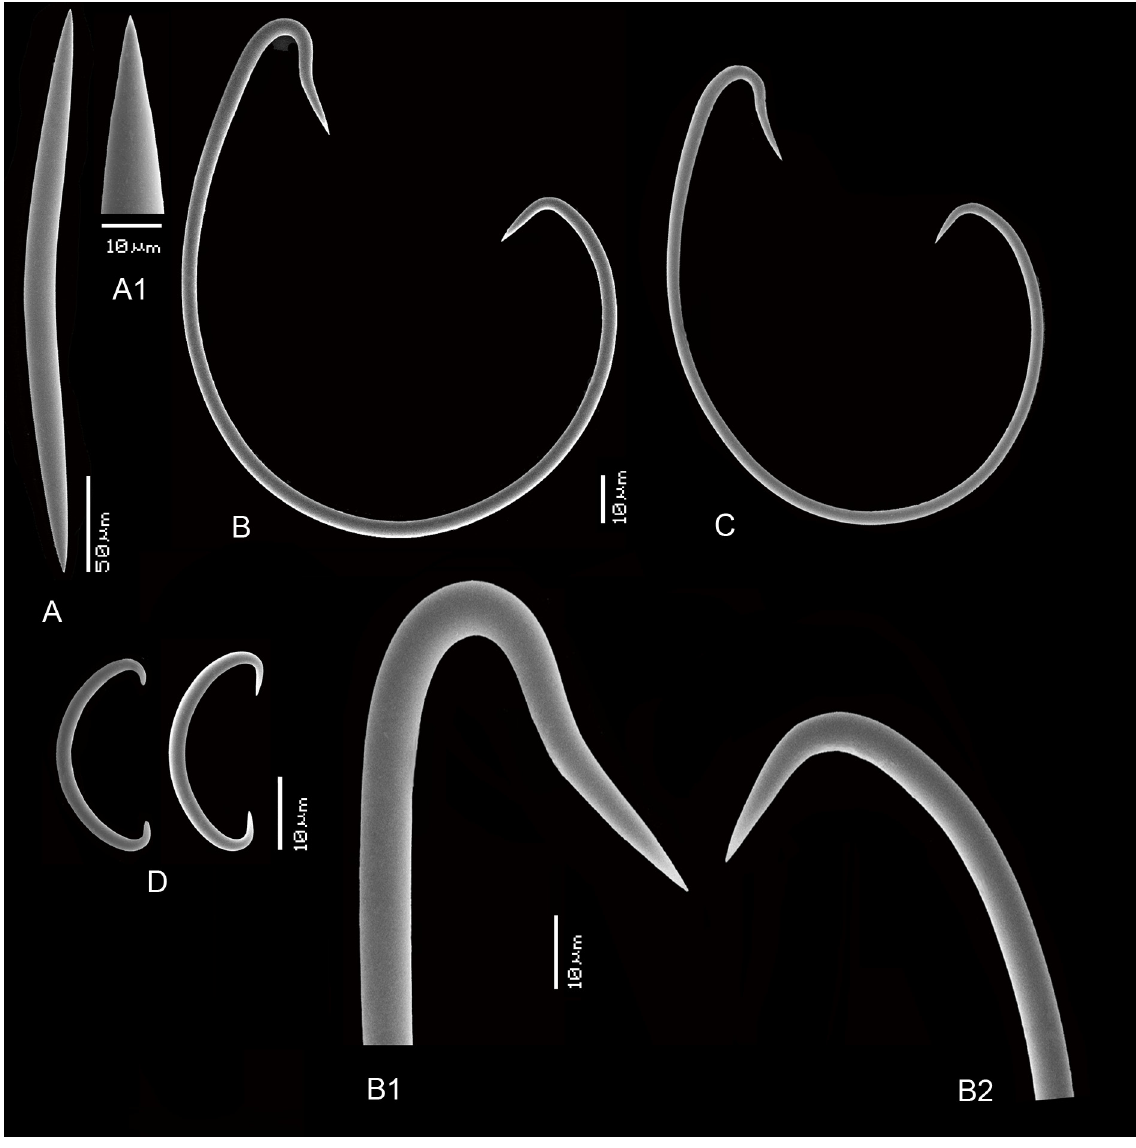
Fig. 6. Haliclona ( Flagellia ) hamata (Thiele, 1903) subgen. et comb. nov., SEM images from a fragment of the holotype (SMF 1640) from Ternate, Indonesia. A . Oxea. A apices. B–C . Flagellosigmas. B . Detail of long ending of flagellosigma. B 1 flagellosigma. D .